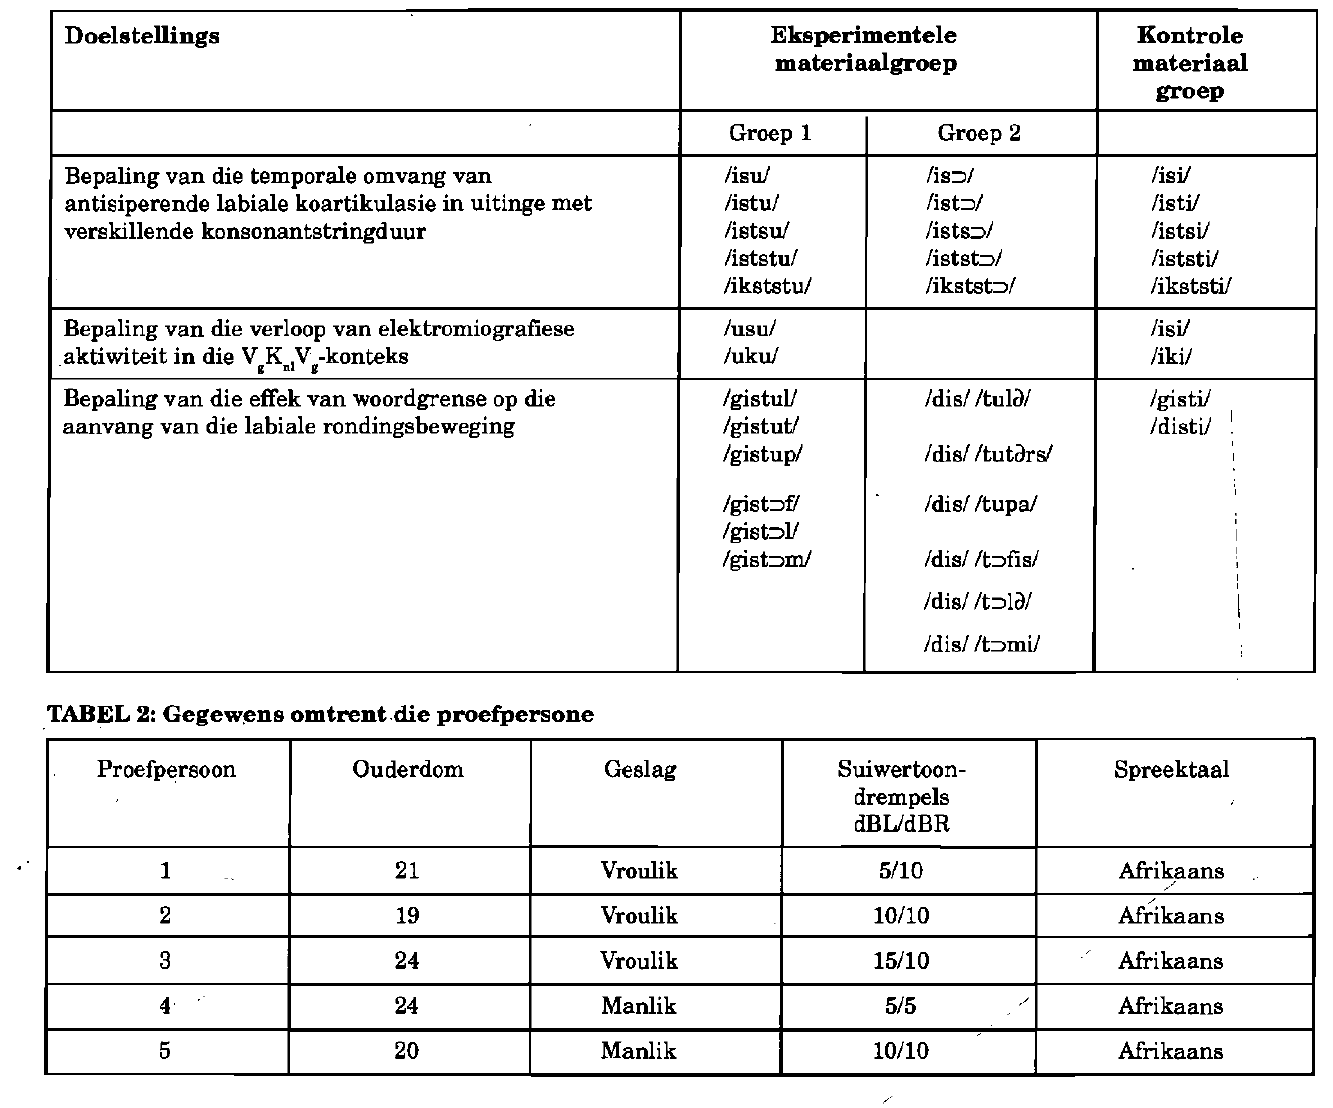
TABEL 2: Gegewens omtrent die